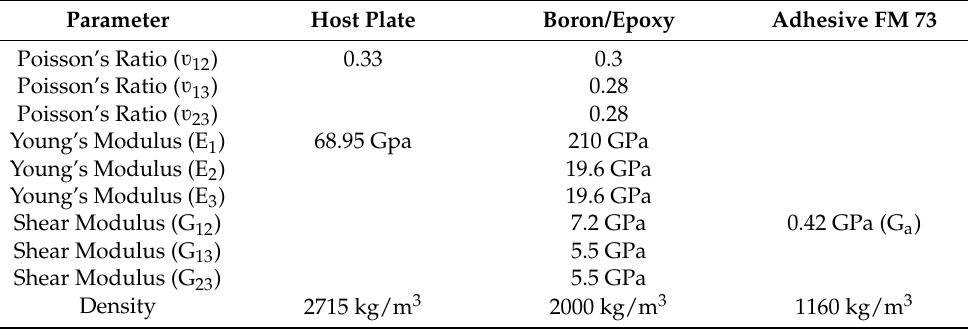
Table 1. Materials properties of the host plate, Boron/Epoxy, and adhesive.